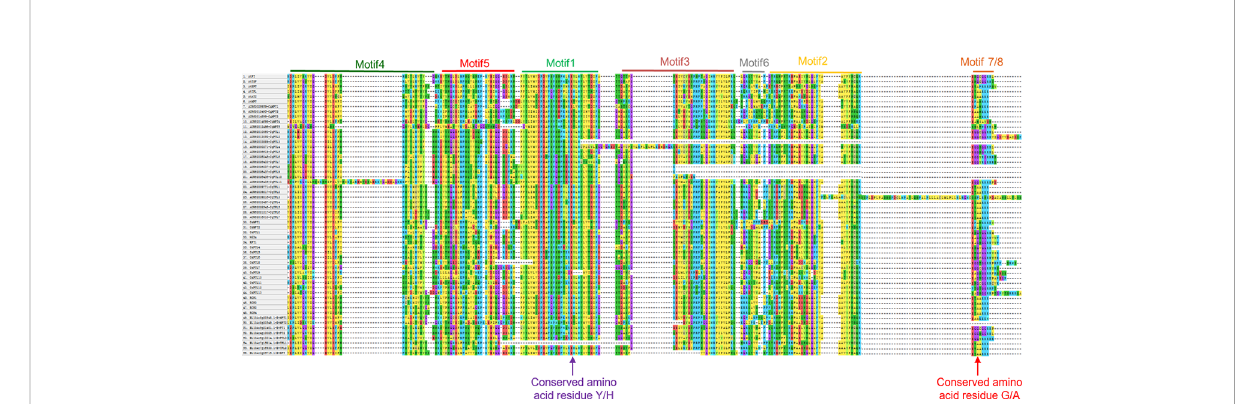
FIGURE 4 Multiple sequence alignment of the PEBP proteins from different plants. Sequences numbered with 1 to 6, 7 to 29, 30 to 48 and 49 to 56 stand for PEBP genes from Arabidopsis, rice, quinoa and sugar beet, respectively. The conserved motif 1 to motif 5 are indicated at the top of aligned sequences. Red arrow indicates the key conserved amino acid residue that determines FT and TFL subclade